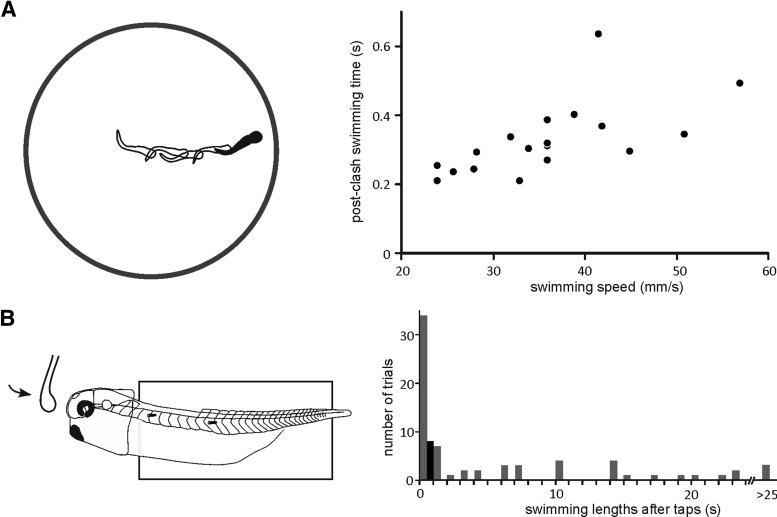
 KO responses in free-swimming and restrained tadpoles. A, KO responses videoed in a dish (left) with swimming speeds plotted against post-clash swimming lengths (right, 18 responses in six tadpoles, p < 0.01, two-tailed Pearson correlation). Post-clash swimming lasts for 0.33 ± 0.02 s (0.21–0.63 s). Tracing shows the tadpole swimming track. B, Simulating head-on clashes in a physically restrained tadpole (left) and the distribution of post-tap swimming lengths. Gray represents single taps (half-cycle sinewave at 20 Hz) and black represents multiple taps (five sinewave cycles at 20 Hz).